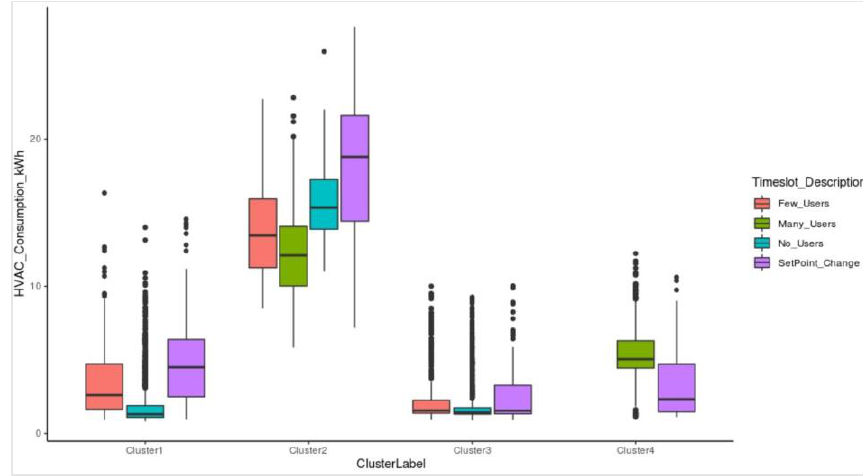
Figure 12. HVAC consumption by cluster label and timeslot type.